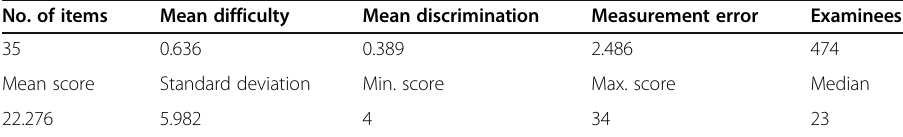
Table 3 Learner response data analysis by